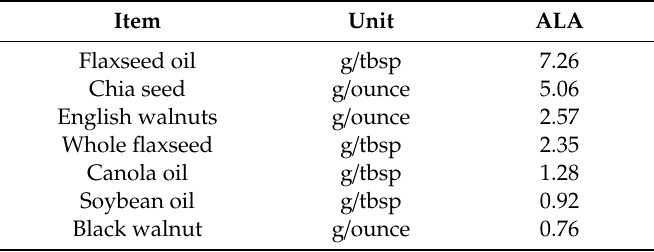
Table 1. Common food sources of ALA (18:3n-3, as gram per